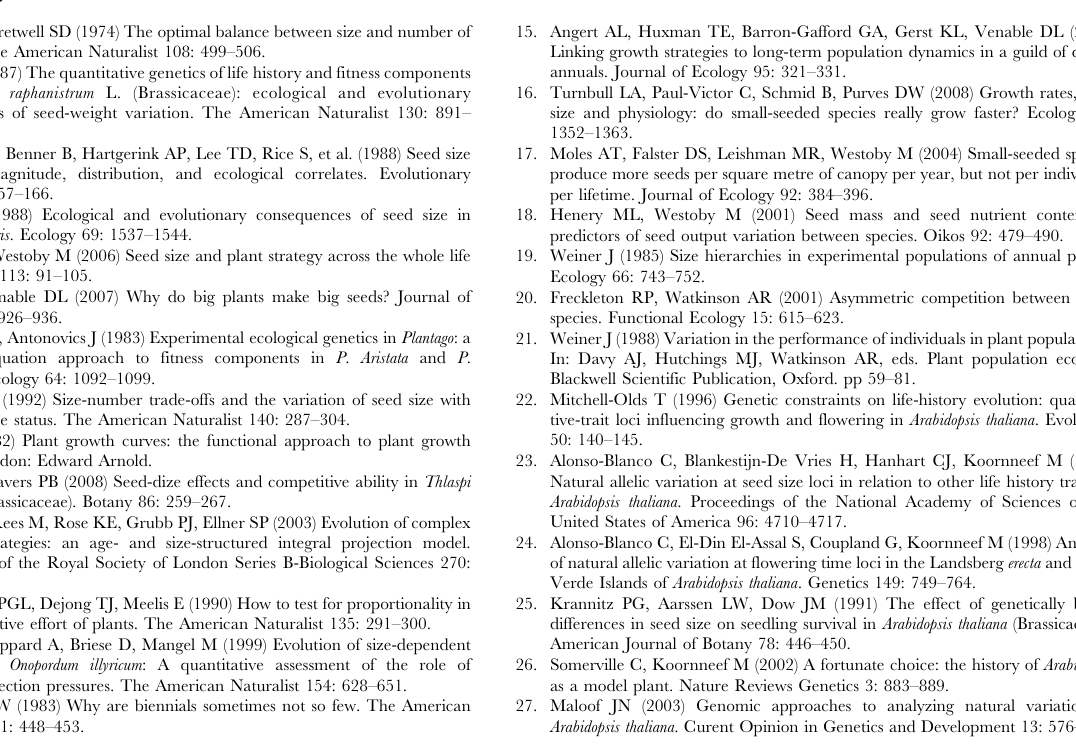
Term Error term Df Sum